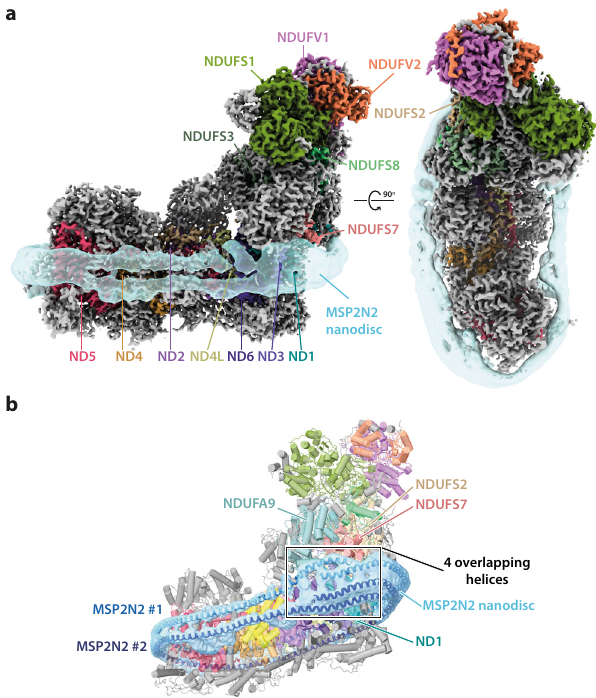
Fig. 1 Overview of the structure of mitochondrial complex I from Bos taurus reconstituted into nanodiscs. a Side and top views of the cryo-EM densities for the 14 core (coloured) and 31 supernumerary (grey) subunits of Q 10 -bound active complex I at a map threshold of 6.5 are shown with the subtract-re fi ned MSP2N2 nanodisc (transparent sky blue) overlaid in UCSF ChimeraX 51 . b Heel view of a representative CxI-ND model (deactive- ligand; cartoon) encapsulated in the subtract-re fi ned MSP2N2 nanodisc map with polyalanine models for the MSP2N2 molecules shown as